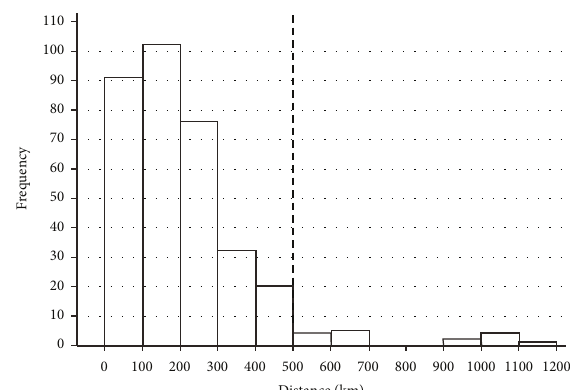
Figure 6: The distance distribution between cities and provincial capital